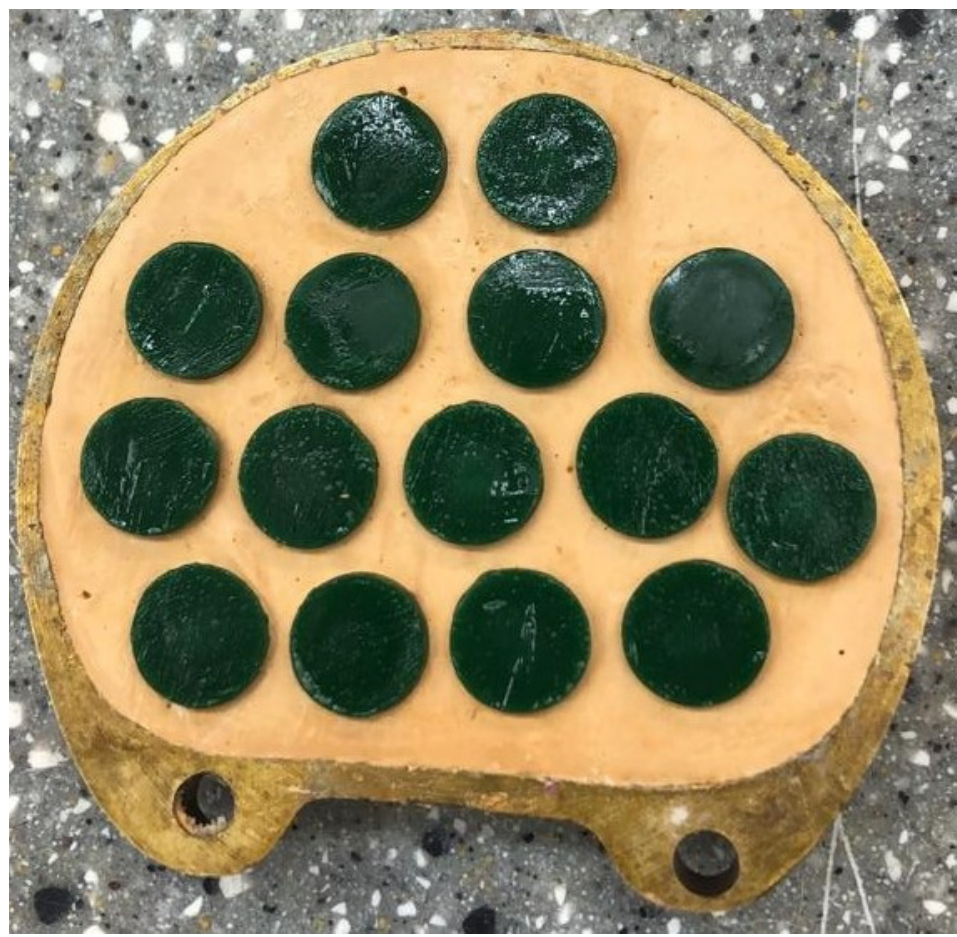
Figure 4. Wax patterns invested for conventional compression molding